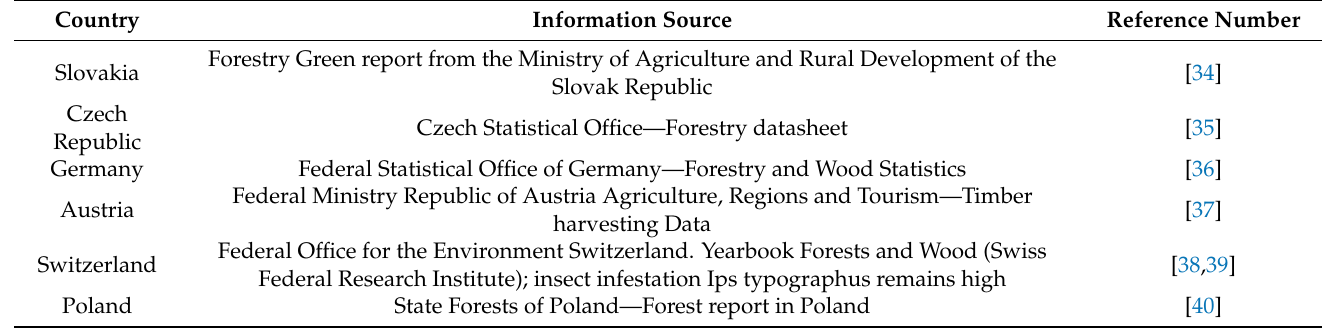
Table 1. Overview of the information sources about incidental fellings for the analysis database according to references. Information